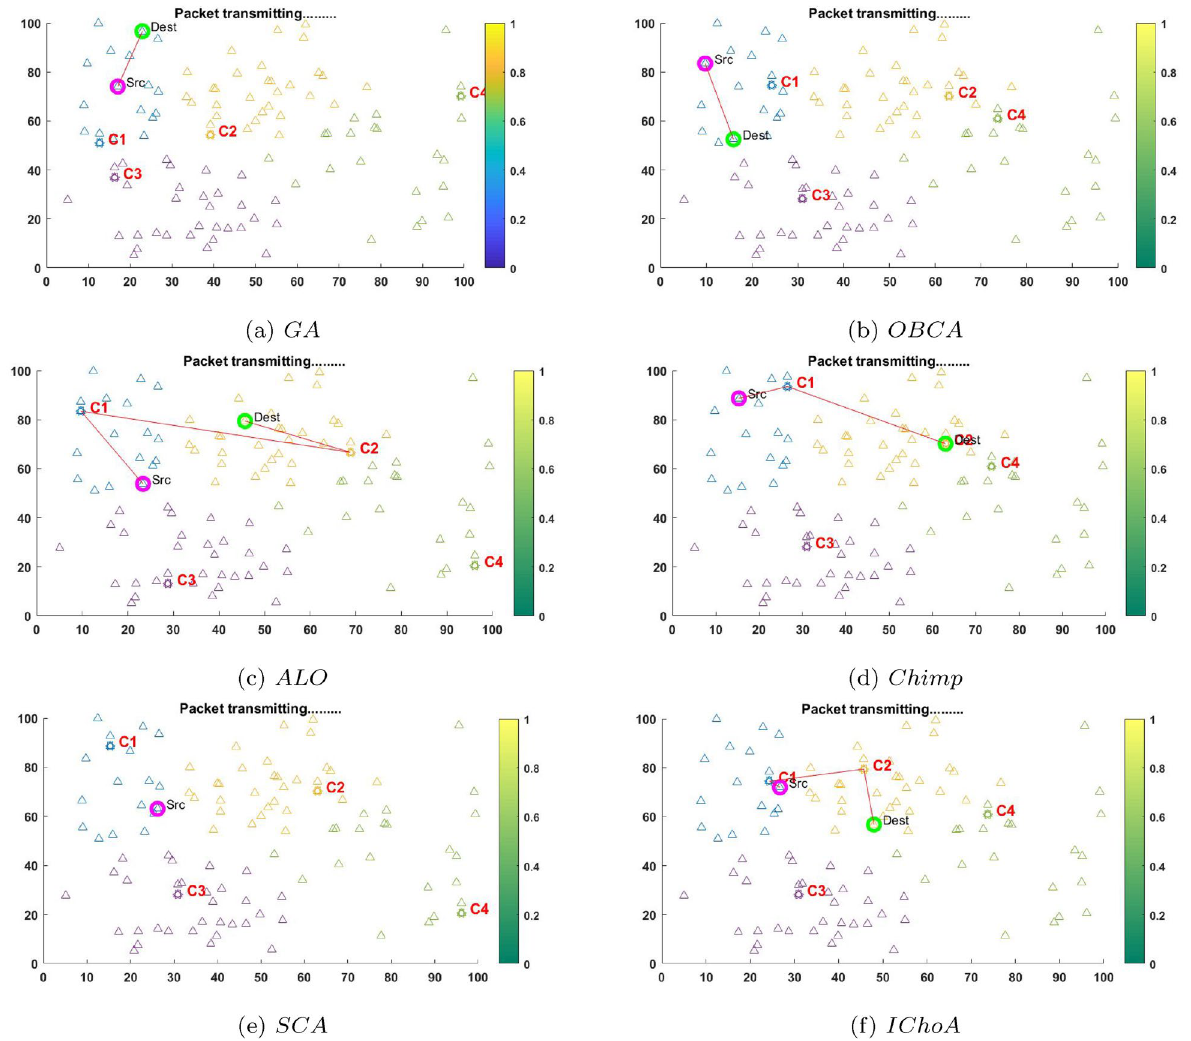
Figure 7. The packet transmitting graphs of metaheuristics on F 2